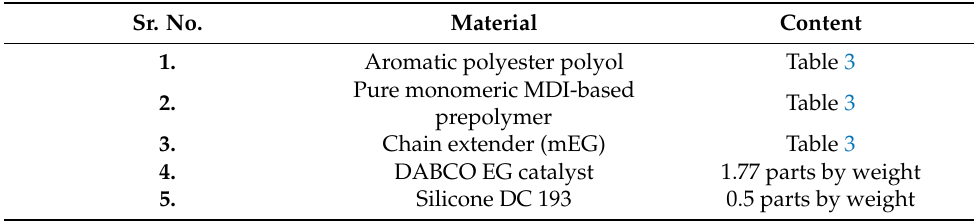
Table 2. Contents of polyurethane elastomer.